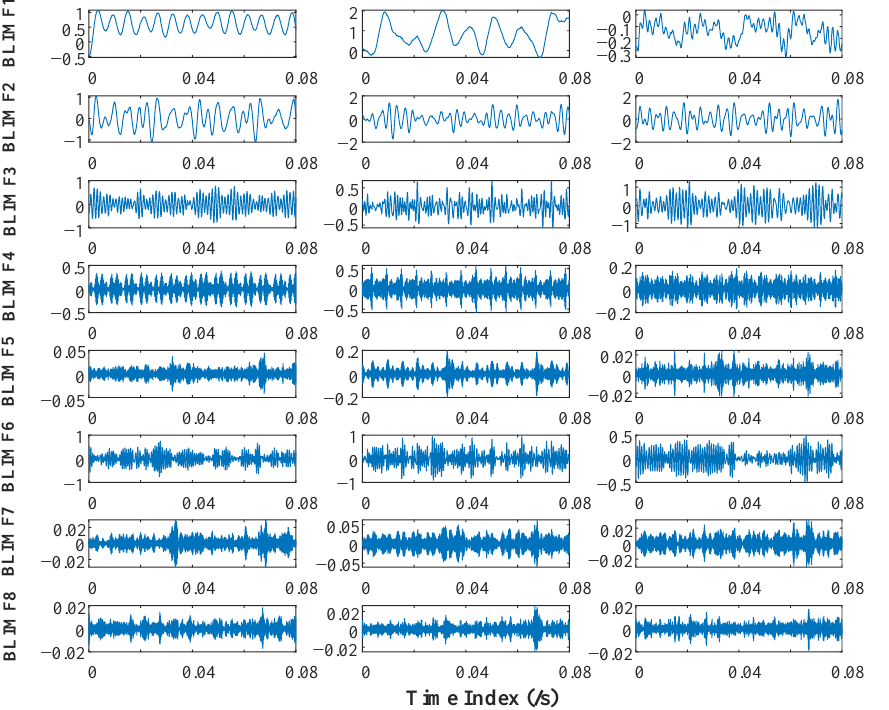
Figure 5. The time spectrum of the first 8 orders BLIMFs generated by MVMD.